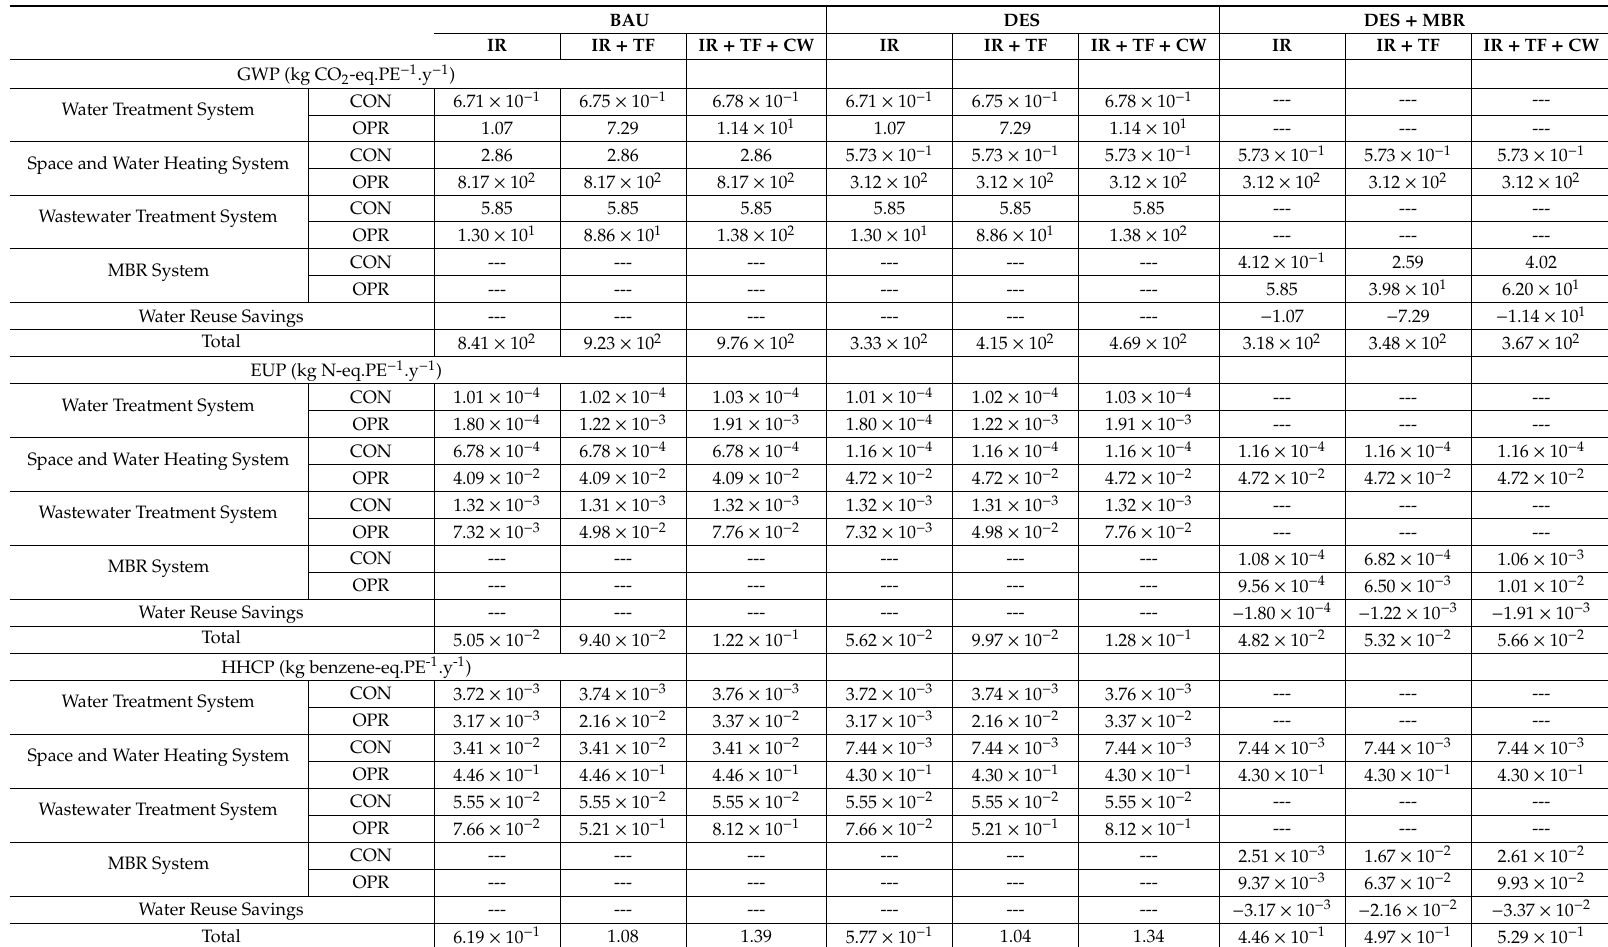
Table 2. Impact contributions of construction and operational phases of system components for BAU, DES, and DES + MBR applications under various water reuse